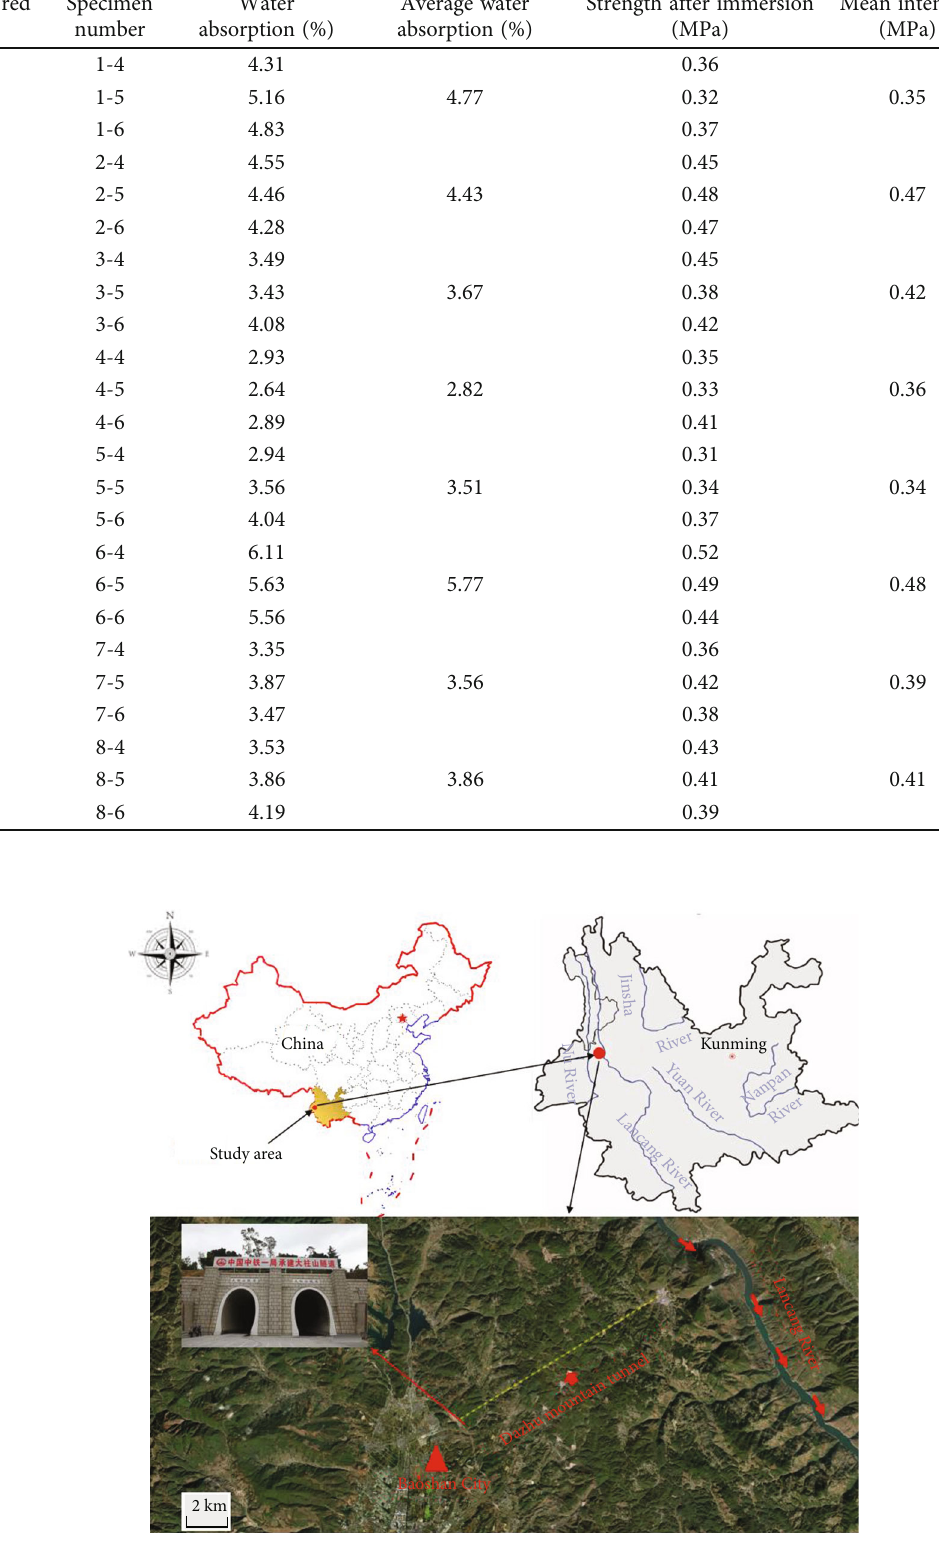
Figure 6: Location plan of Dazhu Mountain